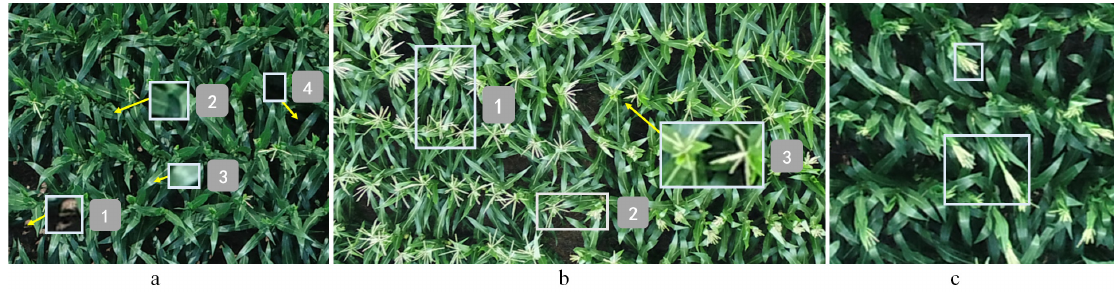
Figure 2. Challenges of maize tassels detection in field. ( a ) Complex background: (1) soil background, (2) green leaf, (3) reflective leaf, (4) shadow. ( b ) Tassels vary in shape and size: (1) (2) tassels vary in shape, and (3) size; ( c ) Tassel pose variations caused by